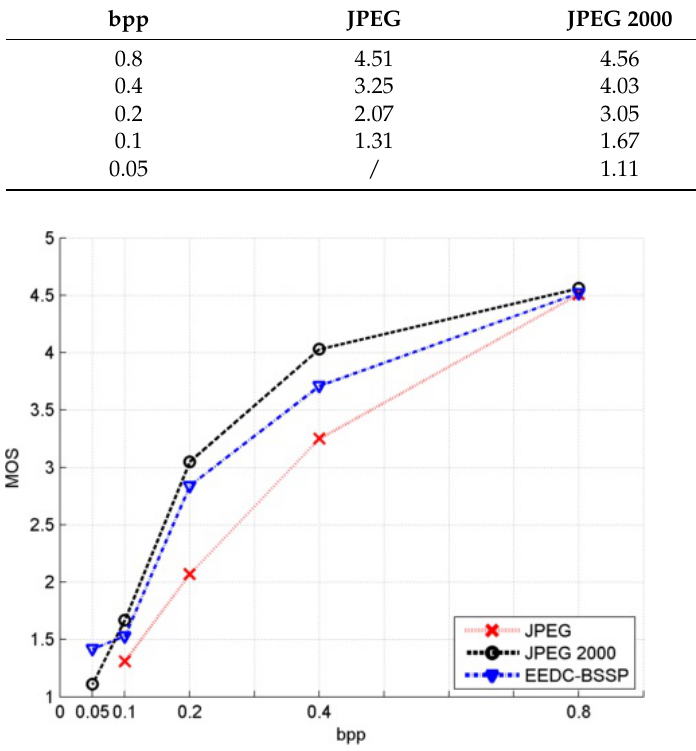
Figure 19. MOS values comparison for EEDC-BSSP with JPEG and JPEG 2000 for image beauty